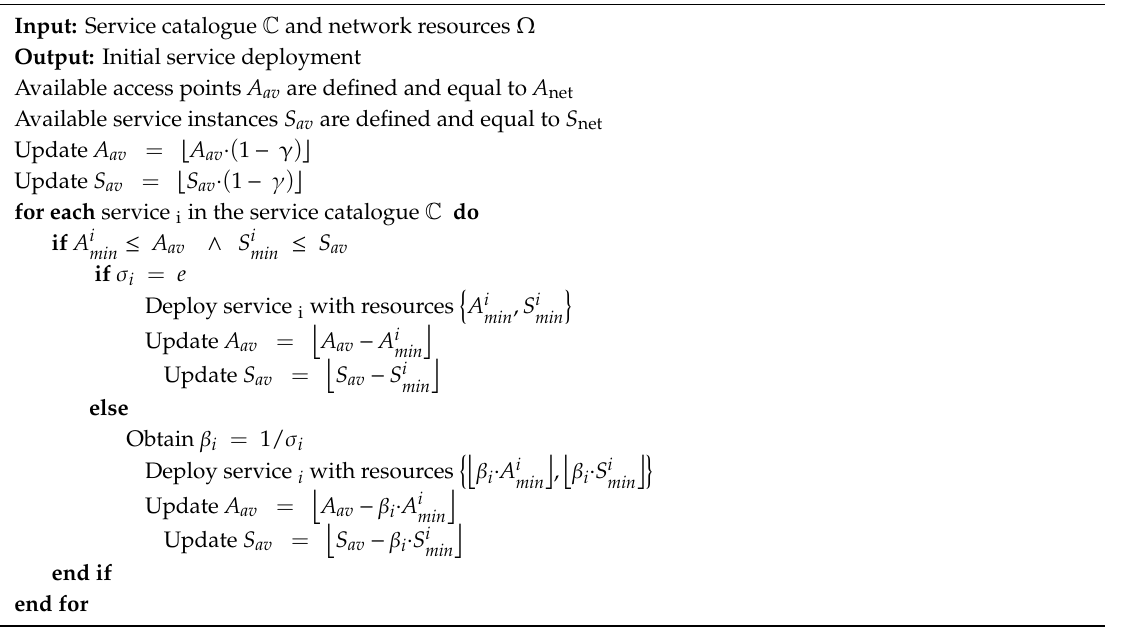
Algorithm 3. Initial Service Deployment